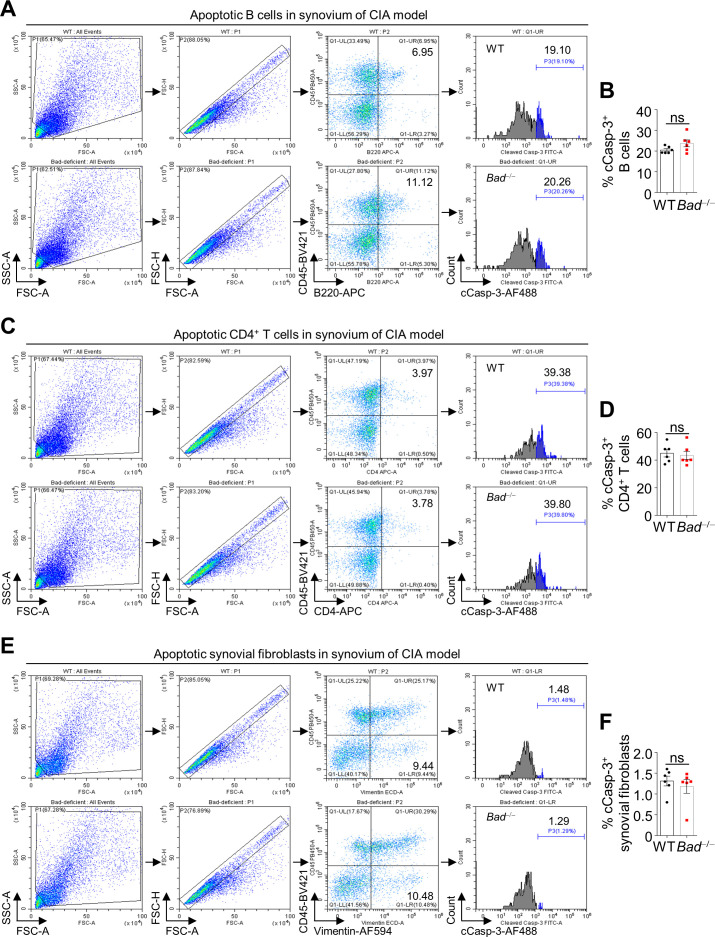
Bad loss does not significantly affect the apoptosis of B cells, CD4+ T cells, or synovial fibroblasts in collagen-induced arthritis (CIA) detected by cleaved Casp-3 staining.(A, C, and E) Apoptotic synovial B cells (A), CD4+ T cells (C), and fibroblasts (E) from wild-type (WT) and Bad−/− mice in CIA model were analyzed by flow cytometry by staining cleaved Casp-3. (B, D, and F) Quantification of the apoptotic B cells (B), CD4+ T cells (D), and fibroblasts (F). All data are presented as mean ± SEM, dots represent individual mice, and n = 6 for each group. Significant difference was analyzed by unpaired Student’s t-test.